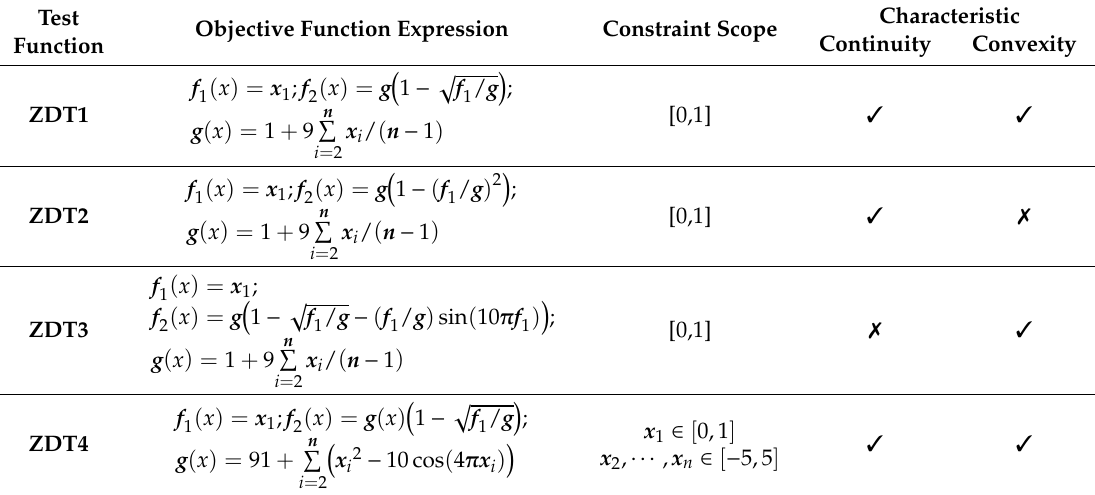
Table 11. Test functions details of multi-objective optimization